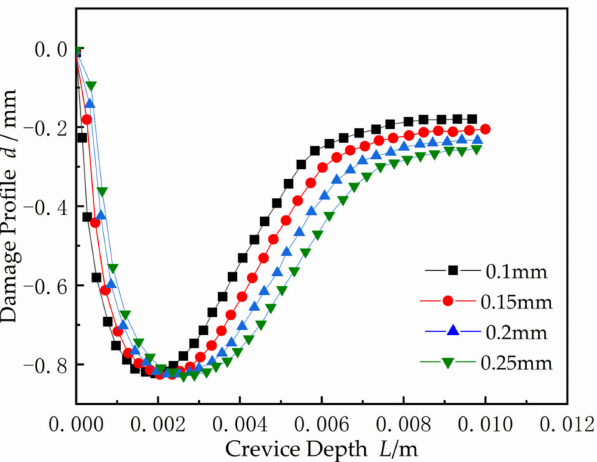
Figure 20. Damage profiles inside the crevice as a function of width W at time t = 50